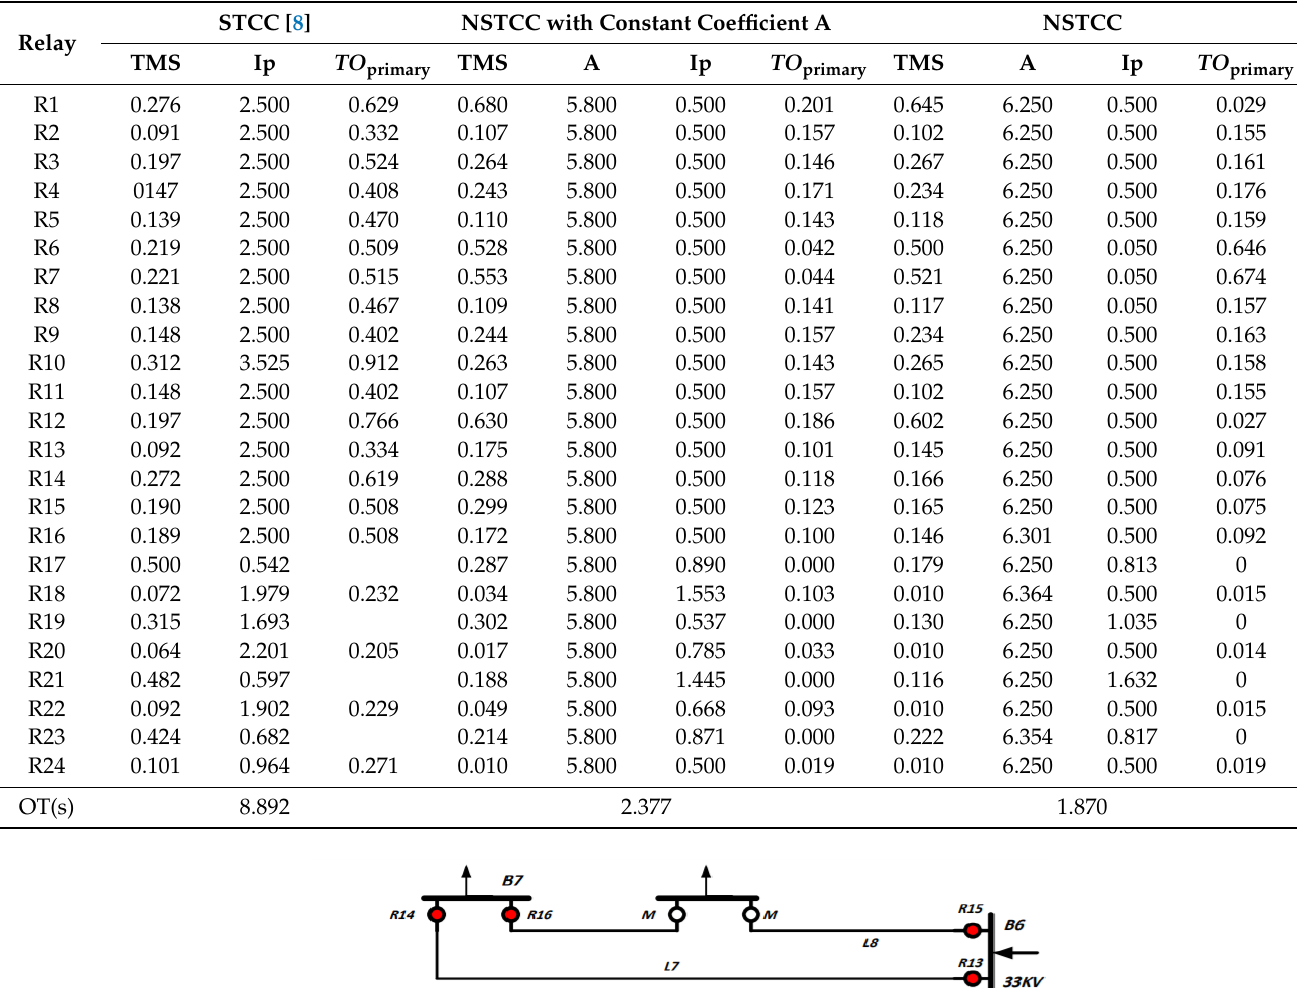
Table 10. Optimal TMS, Ip, and A for the Meshed 9-bus Test System.